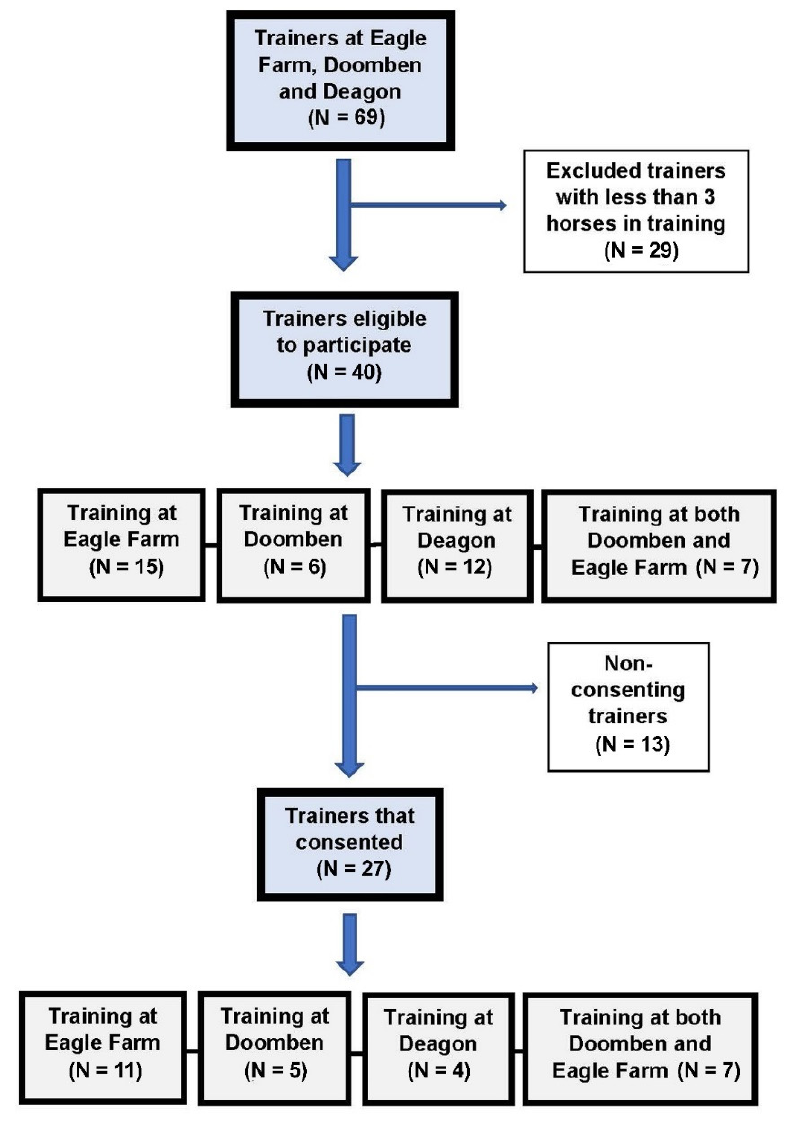
Figure A3. The process used to recruit trainers to provide cases and controls to investigate risk factors for musculoskeletal injuries in Thoroughbred racehorses in South-East Queensland. N = the numbers of trainers at recruitment time at the start of November